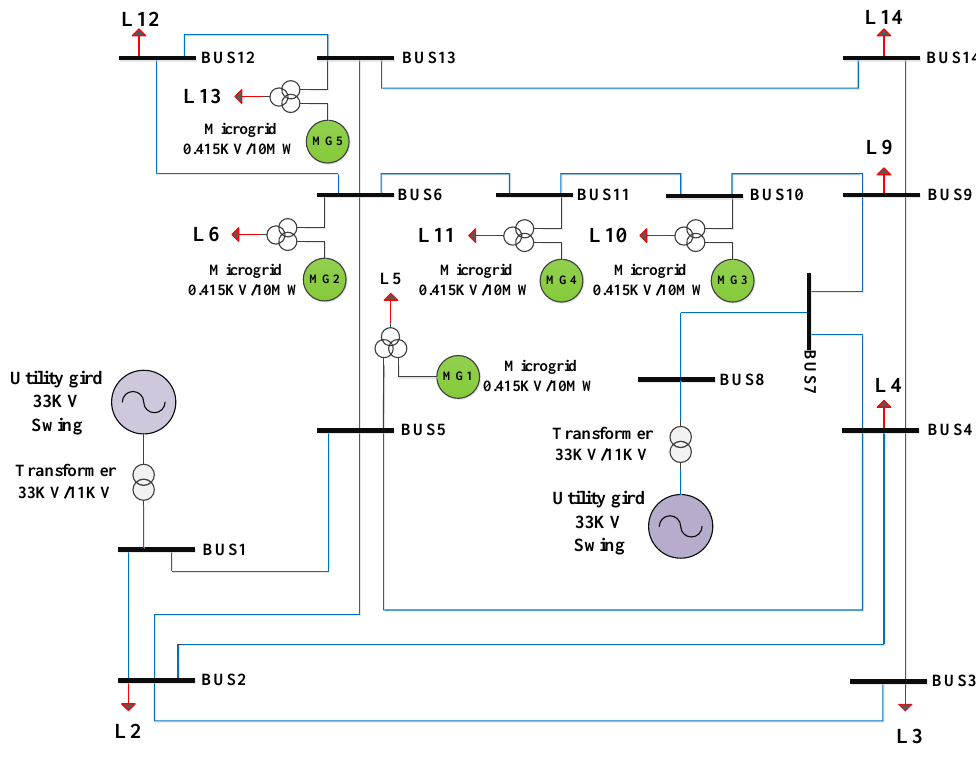
Figure 1. VPP system comprised of IEEE 14-bus test system and five microgrids. Table 1. Active and reactive maximum loading power for each bus bar in MW for the VPP system. Bus